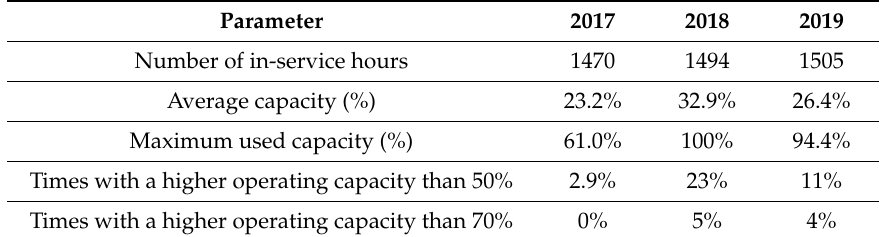
Table 2. The absorption chiller operating statistics when sizing based on the maximum annual cold demand of the case study.